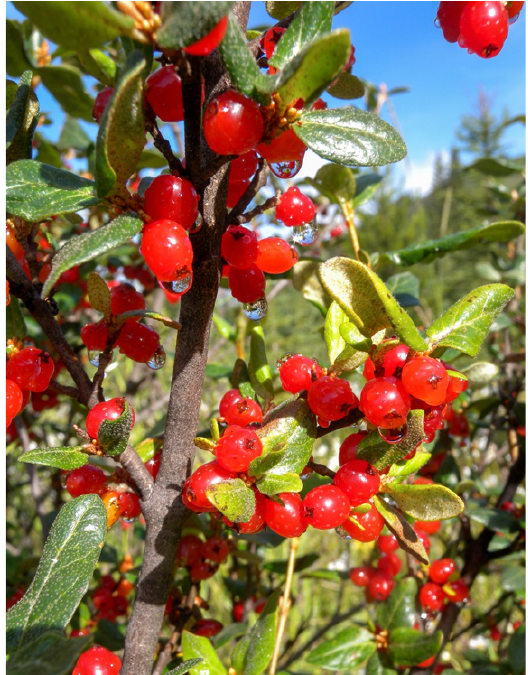
Figure 1. The small and densely packed red fruit of Shepherdia canadensis (Photo by S. E. Nielsen, 31 July 2009).